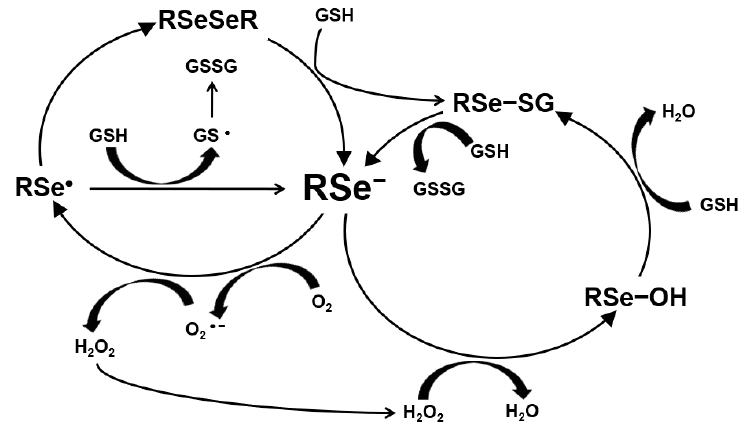
Figure 2. Production of ROS by selenium.